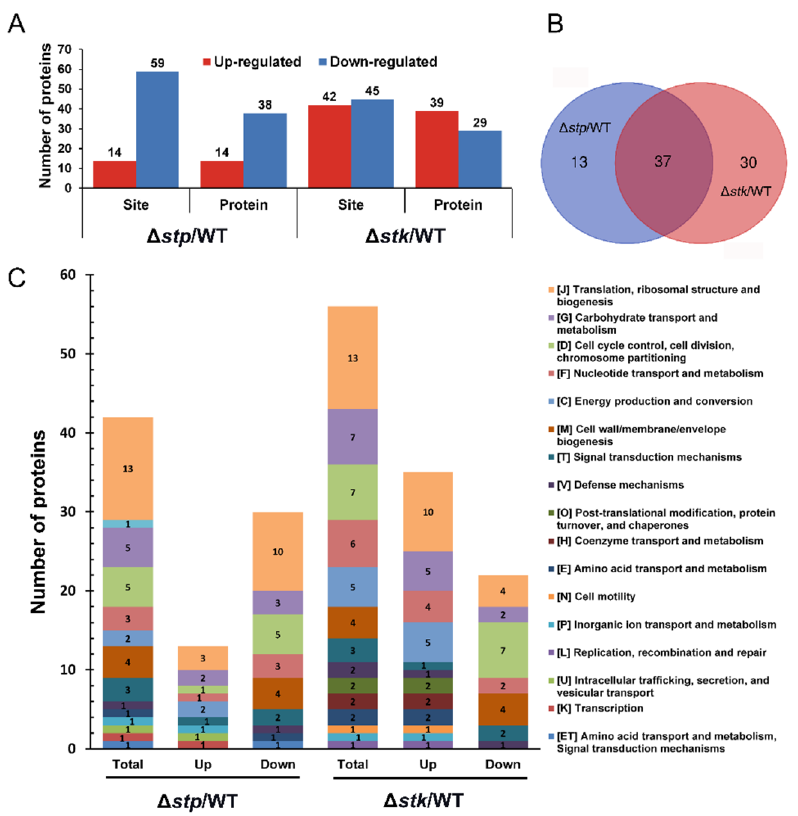
Figure 8. Comparative phosphoproteomic analysis between the WT and ∆ stp or ∆ stk strains. ( A ) Proteins identified with changed abundance after phosphopeptide enrichment between the WT and ∆ stp or ∆ stk strains. ( B ) Venn diagrams showing the proteins with changed phosphorylation levels in ∆ stp and ∆ stk compared with the WT strain. ( C ) COG enrichment of proteins with changed phosphorylation levels in the ∆ stp and ∆ stk compared with the WT strain. The COG enrichment analysis was performed using the EggNOG v5.0 database (http://eggnog5.embl.de/#/app/home (accessed on 25 June 2021)).